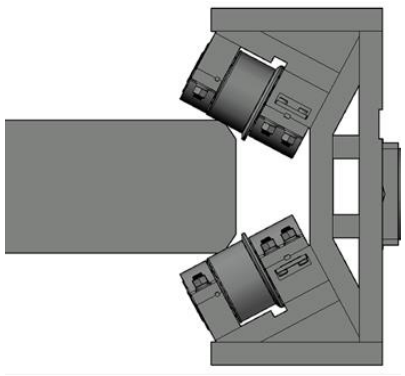
Figure 4. Schematic diagram of vertical rolling at the chamfered slab corner.